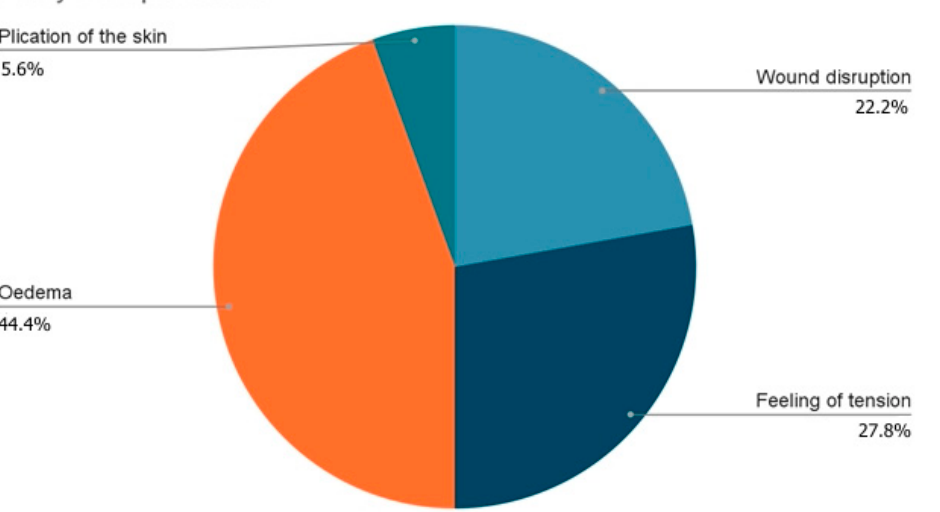
Figure 10. Distribution of early complications.